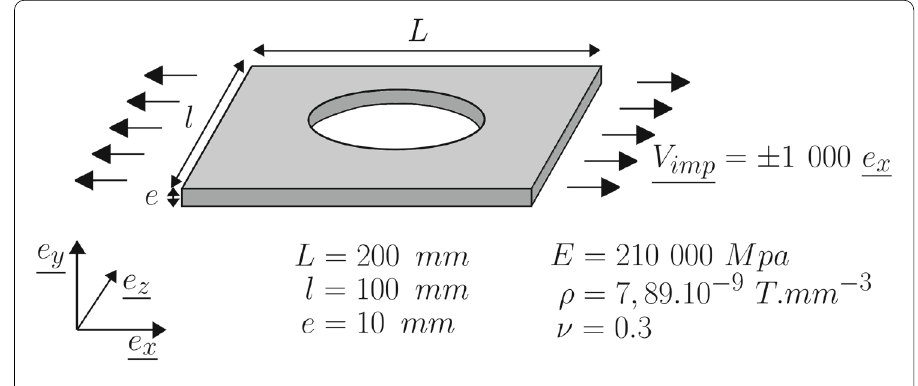
Fig. 1 Test case model scheme